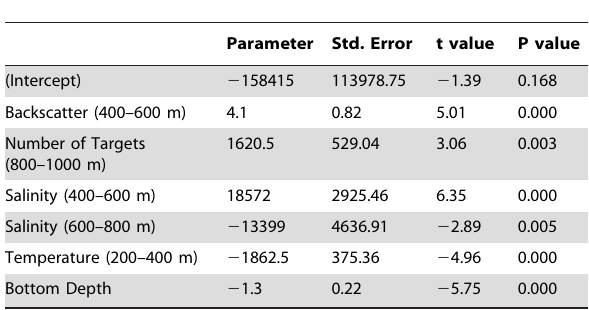
Table 1. Final generalized linear model output and significance values.